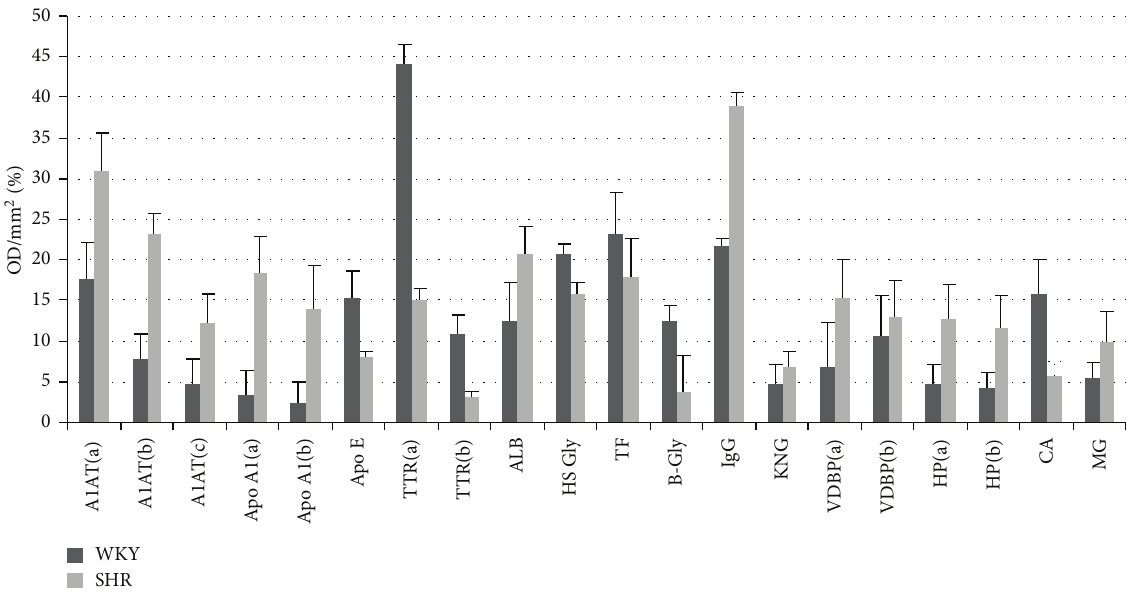
F 5: Differences in optic density between differential proteins of CSF from WKY and SHR. Abbreviations: A1AT: